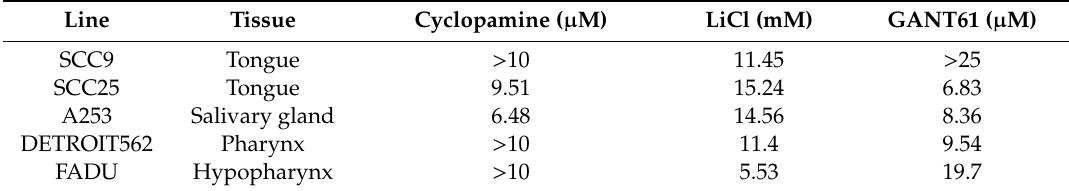
Table 1. Median lethal dose (LD50). LD50 values for each of the tested compounds.